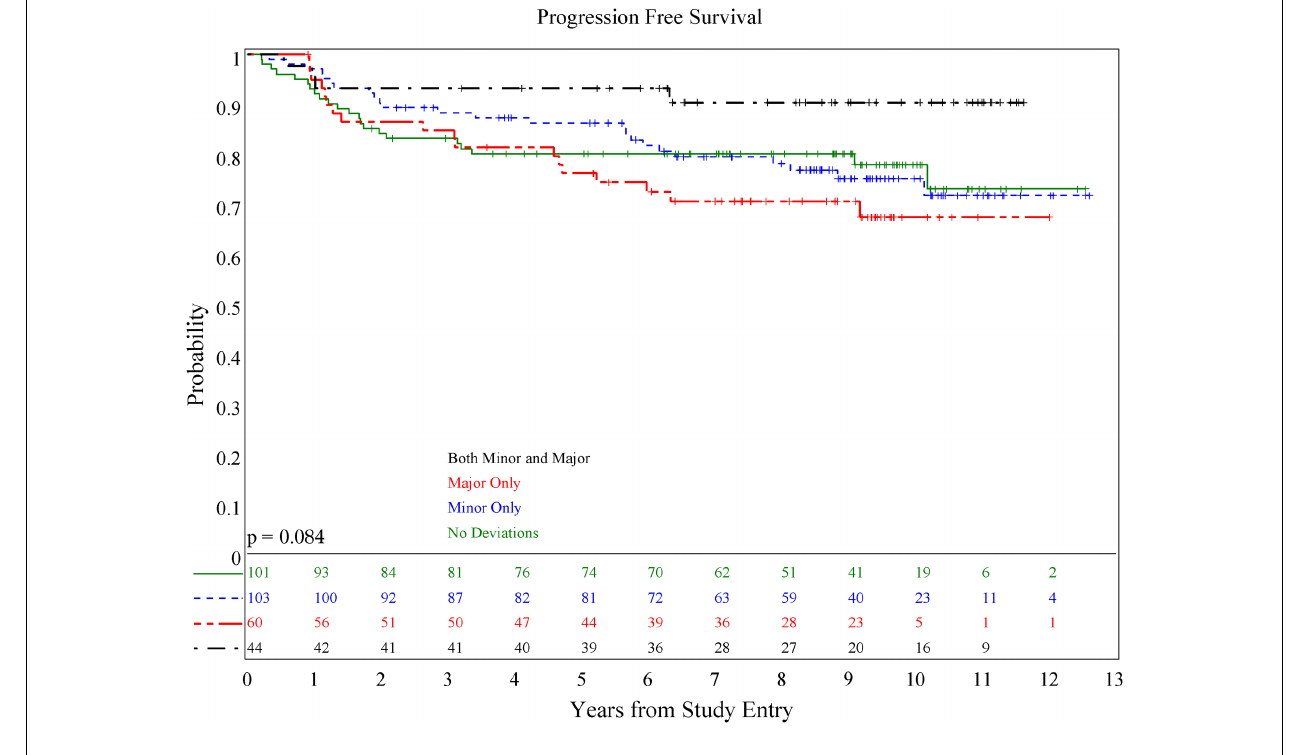
FIGURE 1 |Association of RT deviations and progression-free survival.